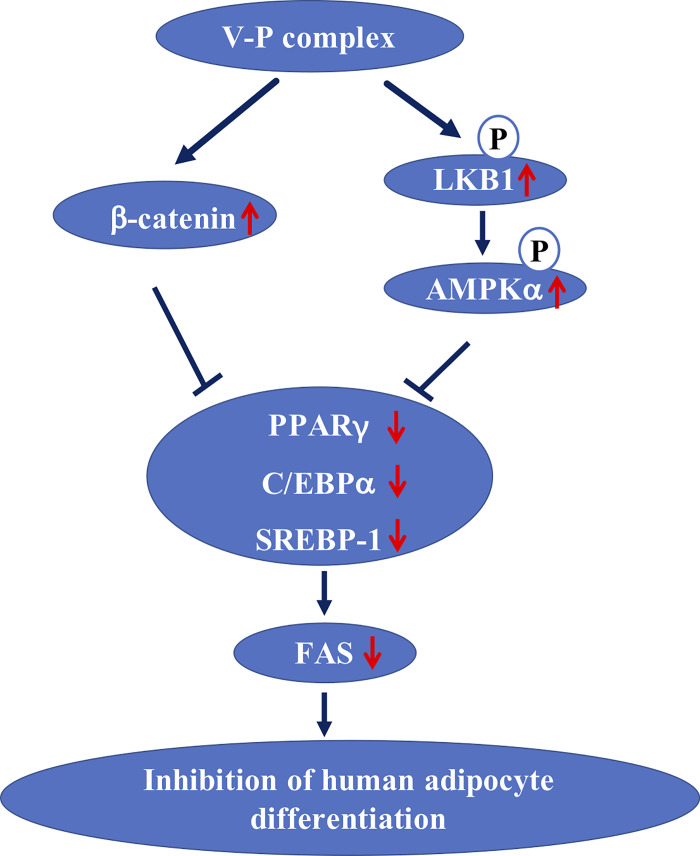
A hypothesis of the molecular mechanism of the inhibitory effect of V-P complex on the adipogenesis in human preadipocytes.Black arrow proposed pathway, red arrow indicated the effects, T inhibition.